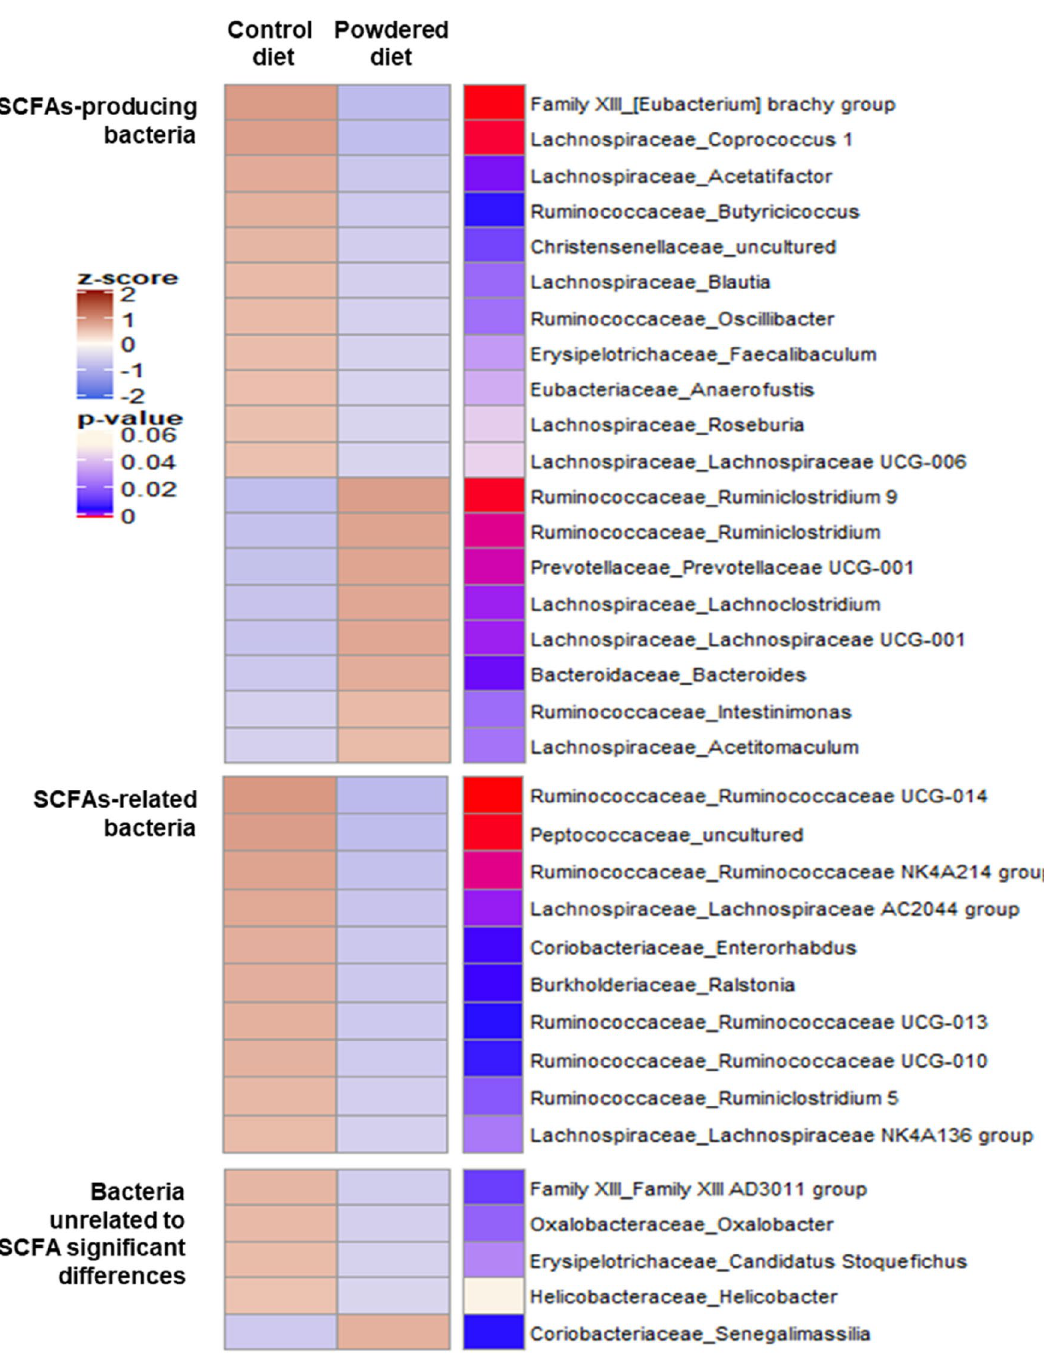
colonic motility, we employed our mastication-like behavior (gnawing) model (2 h) and measured its effect on colonic motility after long-term feeding with a powdered diet 21 . As shown in Fig. 7a, the number of fecal pel- lets was significantly higher in the R + G + group than in the R + G− group. Indeed, as shown in Fig. 7b, the level of Ly-6G and AQP-4 was significantly lower in the colon tissues of the R + G + group than in the R + G− group